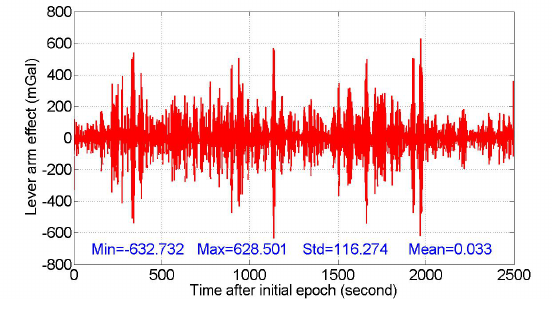
Figure 8. The simulated lever-arm effect.